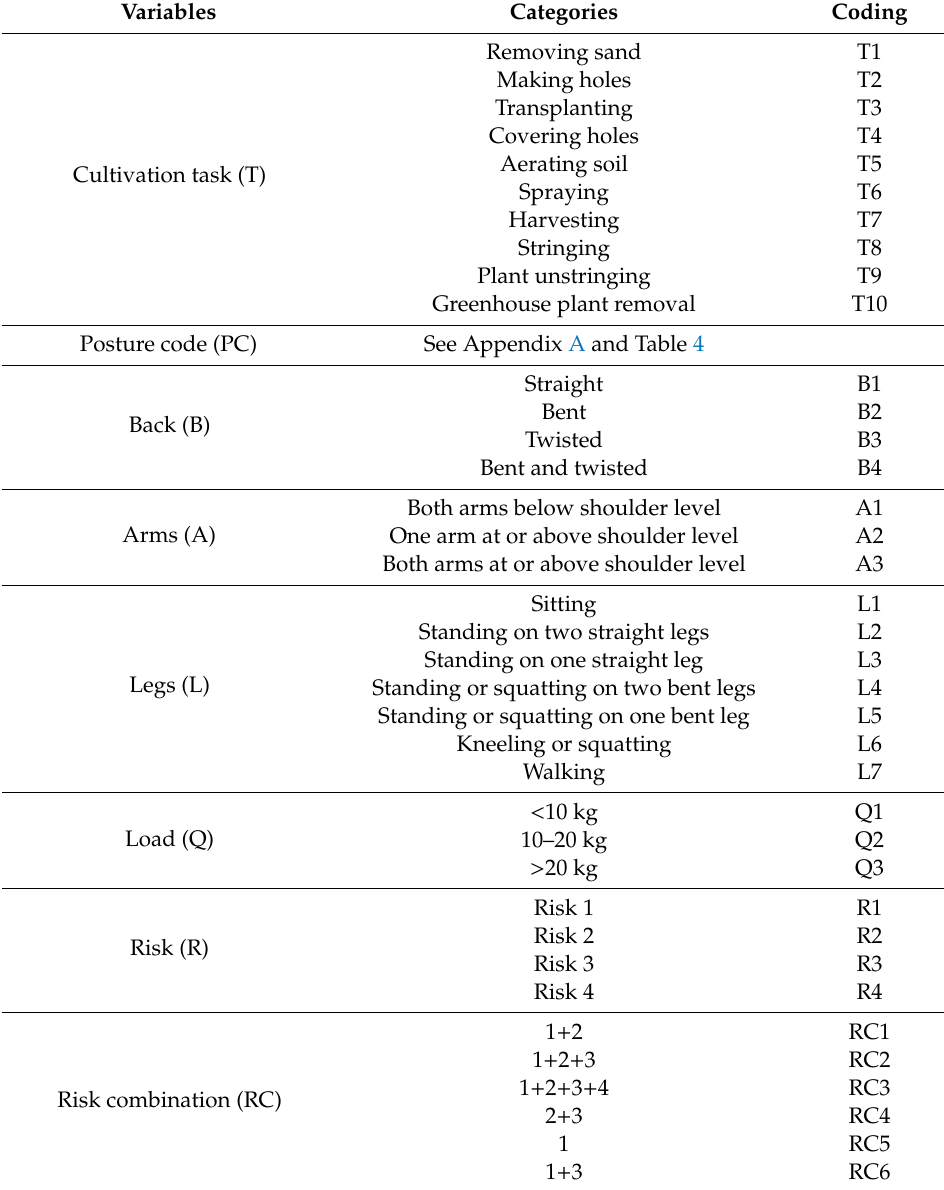
Table A1. Variables and variables categories analyzed in the multiple correspondence